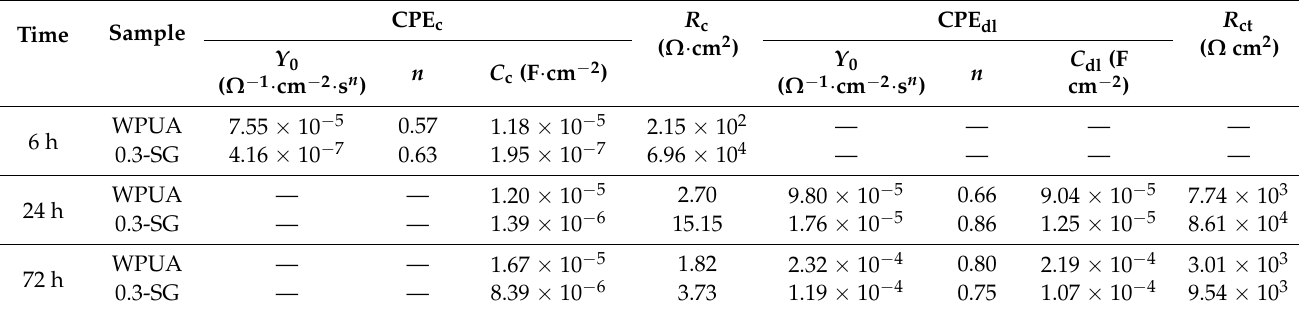
Figure 10. Nyquist plots of WPUA ( a ) and 0.3-SG ( b ); electrical equivalent circuit diagrams fitting Nyquist plots for immerse to 6 h ( c ), 24 h, and 72 h ( d ). Table 3. The electrochemical parameter data of WPUA and 0.3-SG samples immersed for 6, 24, and 72 h. Time